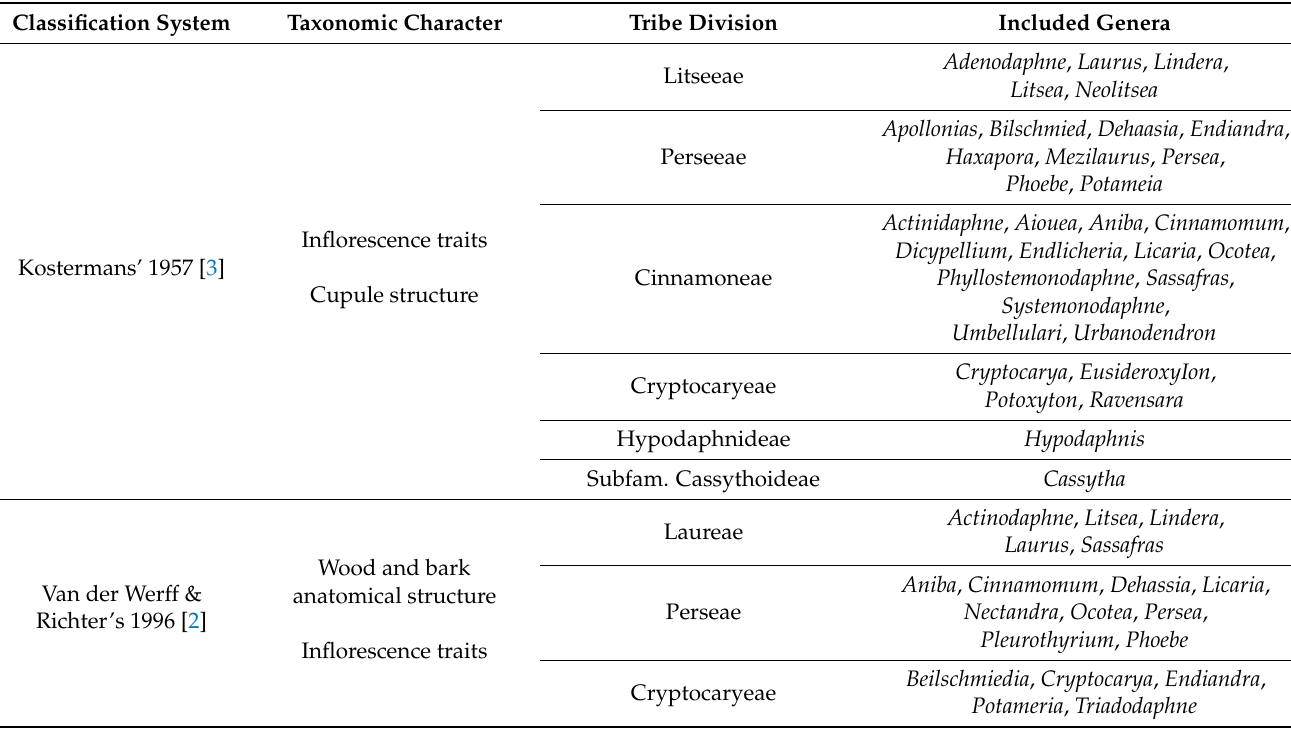
Table 1. Comparison of the Kostermans’ and van der Werff’s